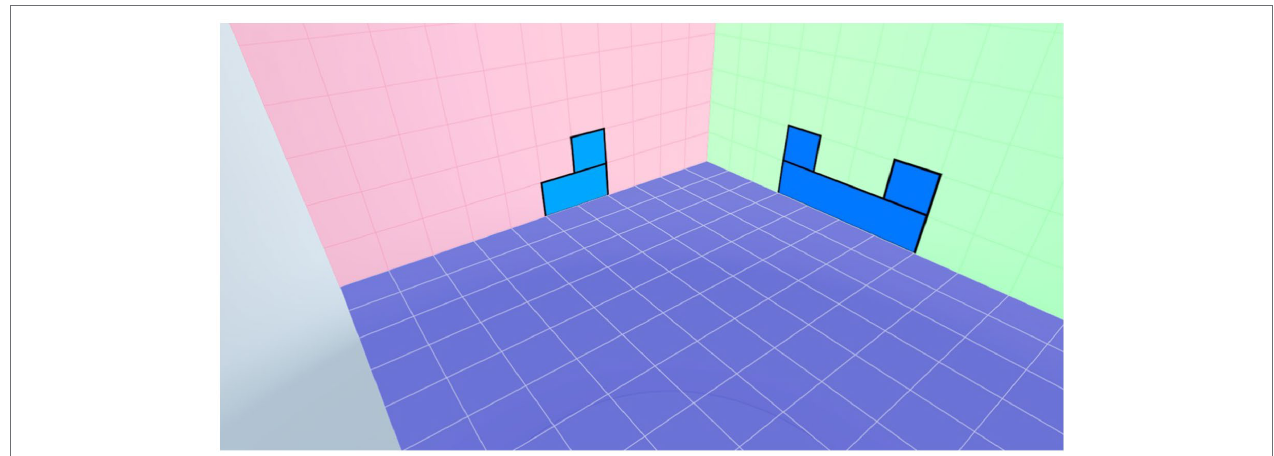
FIGURE 6 | A screenshot of target dimensions: VR assessment example.